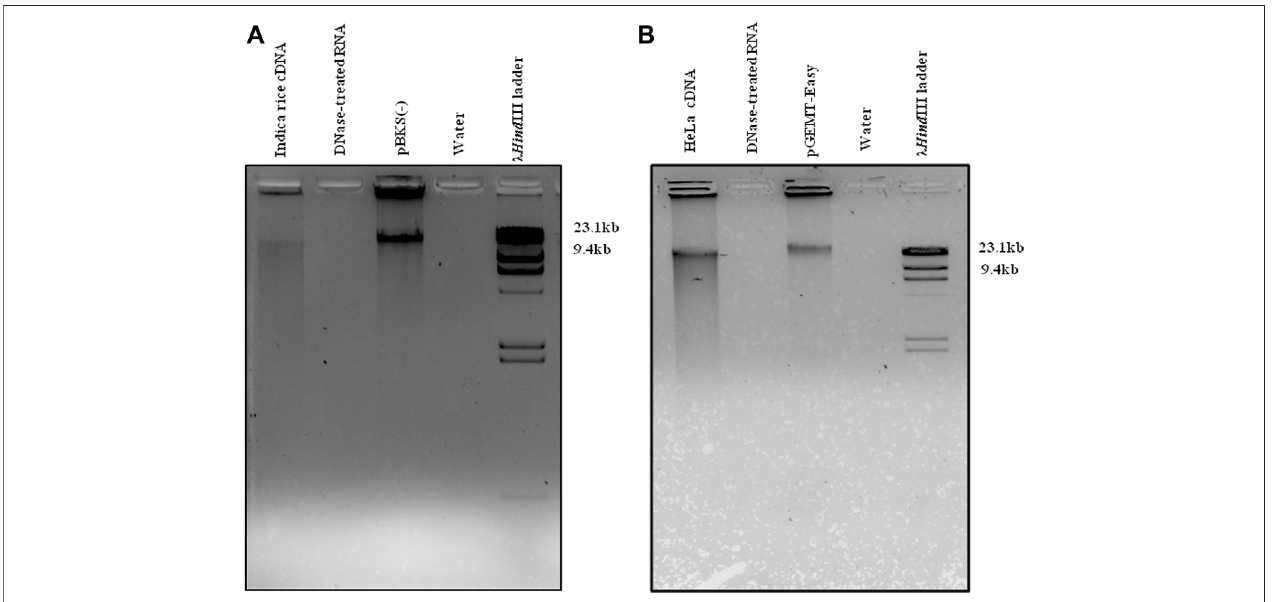
FIGURE 1 | tdMDA in rice and HeLa. cDNA from (A) rice and (B) HeLa cell lines was incubated with phi29 DNA polymerase and 30 µM exo-resistant random pentamerat28 ° Cfor21 h,whichdisplayedtdMDAalongwiththepositivecontrol(pBKS(-)andpGEMT-Easy),whereasDNase-treatedRNAandwaterdidnotshowany TIA. The λ Hind III (Thermo Fisher Scienti fi c) ladder was loaded as a marker.